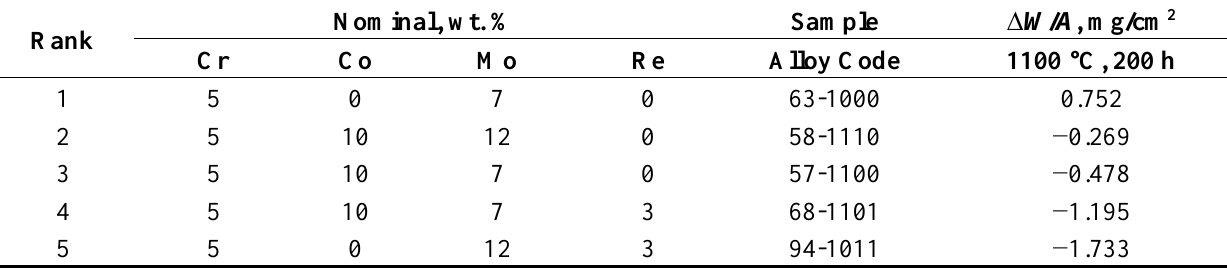
Table 1. Alloy designation, nominal chemistry, and ranked mass change after cyclic oxidation of 12 LDS alloys for regression model. (Base alloy contains 7 Mo, 6 Al, 6.2 Ta, 50–100 ppm Y, and 80–100 ppm